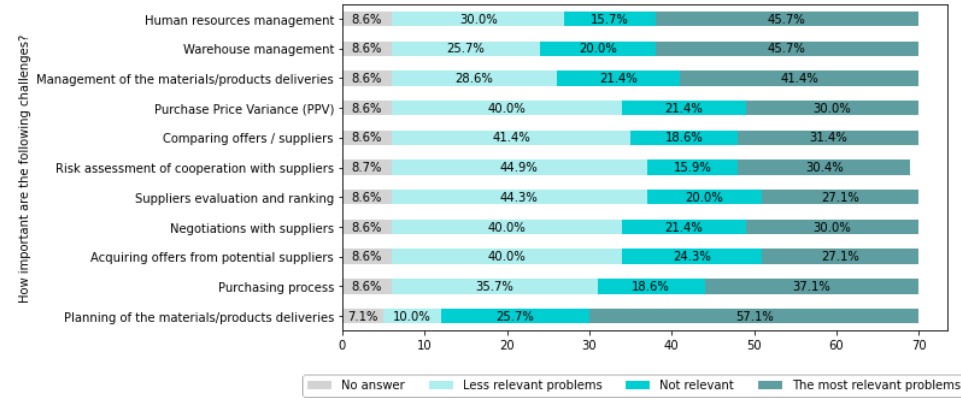
Figure 17. Challenges related to manufacturing process preparation — number of questionnaires in a total number of 70 questionnaires.